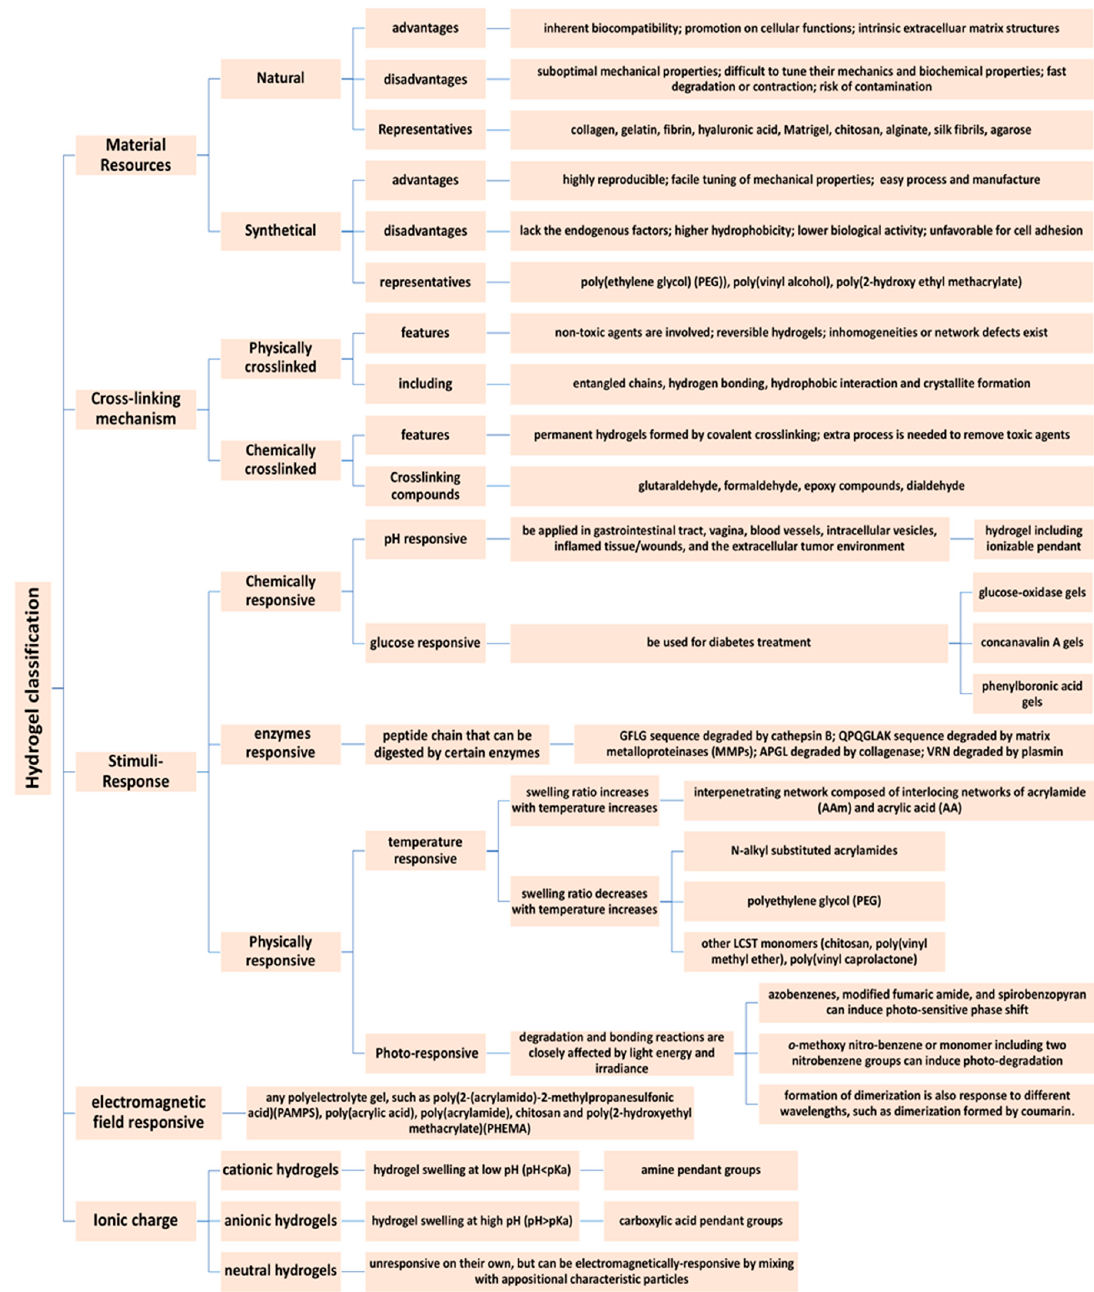
Figure 3. Hydrogel types classified according to chemical and physical properties [36–40].